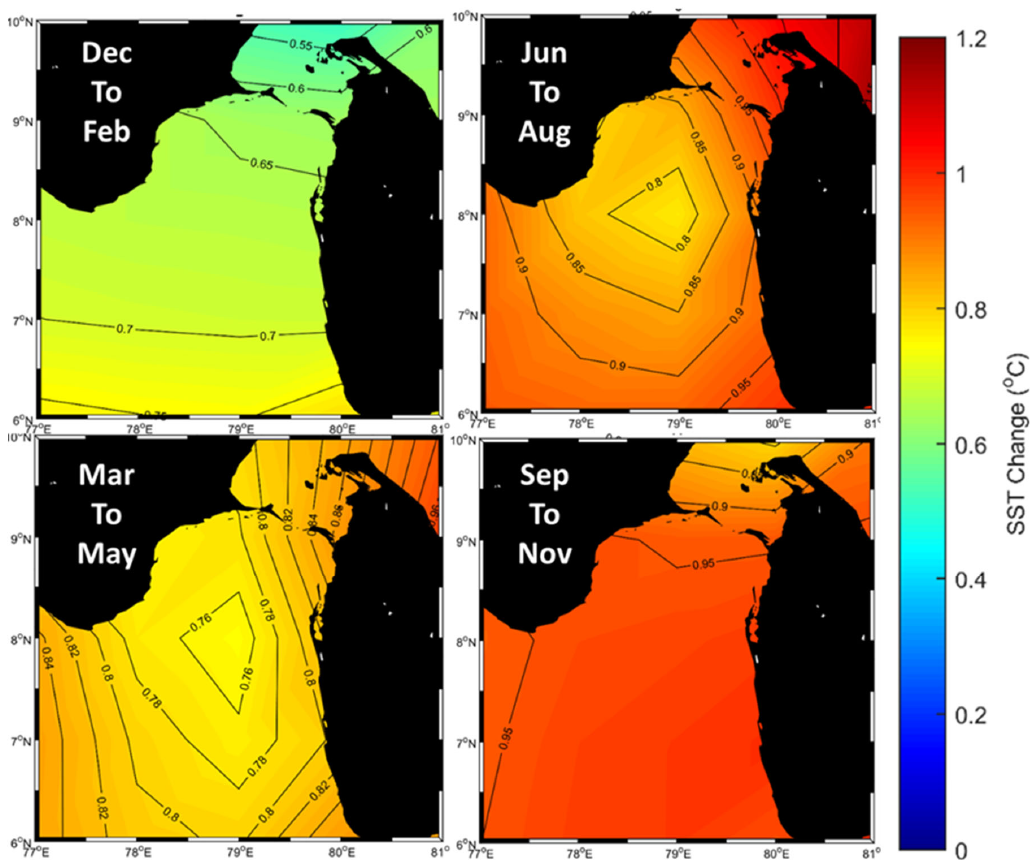
Figure 11. Seasonal changes in SST in the GoM from 1870 to 2018.